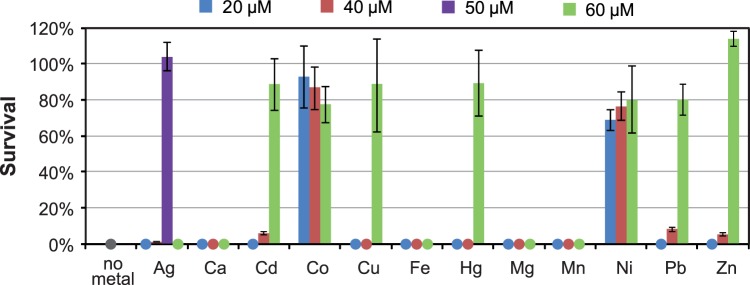
Effect of metals on the toxicity of 50 µM sodium selenide.Before plating on rich medium, DTY7 cells were exposed for 5 min to mixtures containing 50 µM sodium selenide and varying concentrations of the indicated metal salts. Colonies were counted after two days of growth. Shown in ordinate are the percentages of survival relative to controls performed in the absence of selenide and metal. Data of the histogram were obtained with 20 µM (blue), 40 µM (dark red), 50 µM (violet) and 60 µM (green) metal. Control experiment with no metal is in grey. Range bars at the top of the histogram bars were deduced from duplicate experiments.